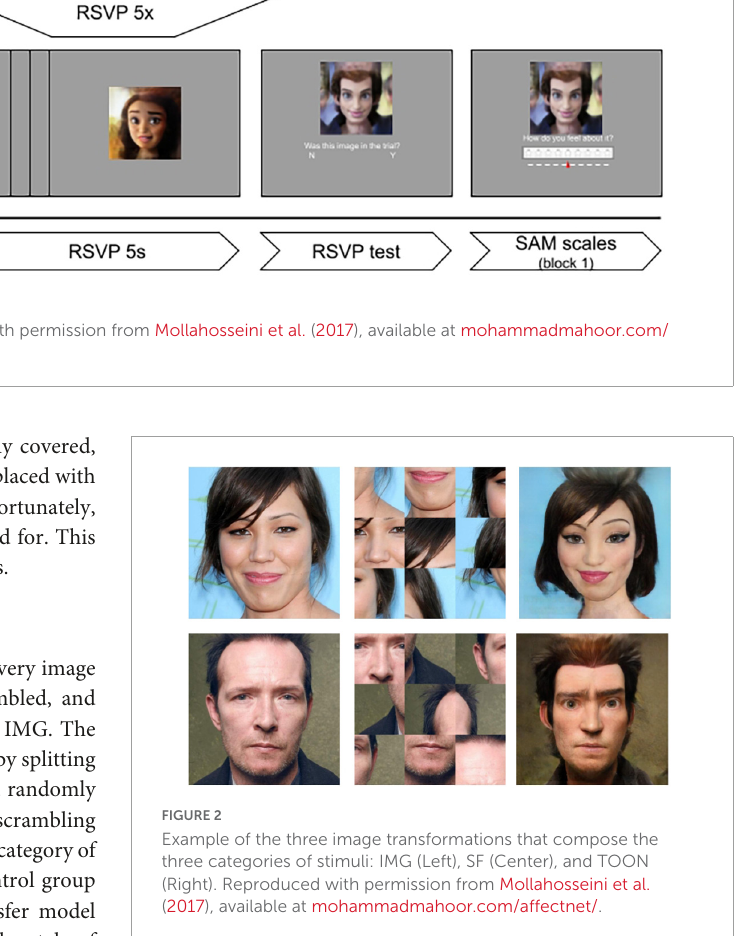
F7, FC5, FC1, Cz, C3, T7, CP5, CP1, P3, P7, Pz, O1, Oz, O2, P4, P8, CP6, CP2, C4, T8, FC6, FC2, F4, F8, and Fp2, as seen in Figure 3